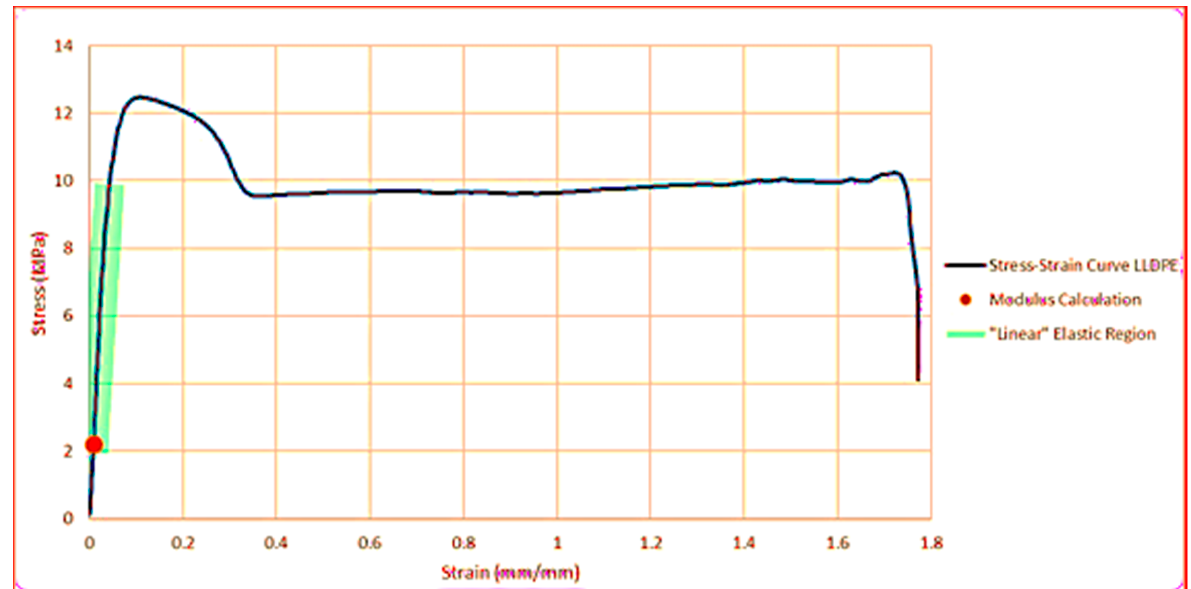
Sustain. Chem. 2021 , 2 , FOR PEER REVIEW